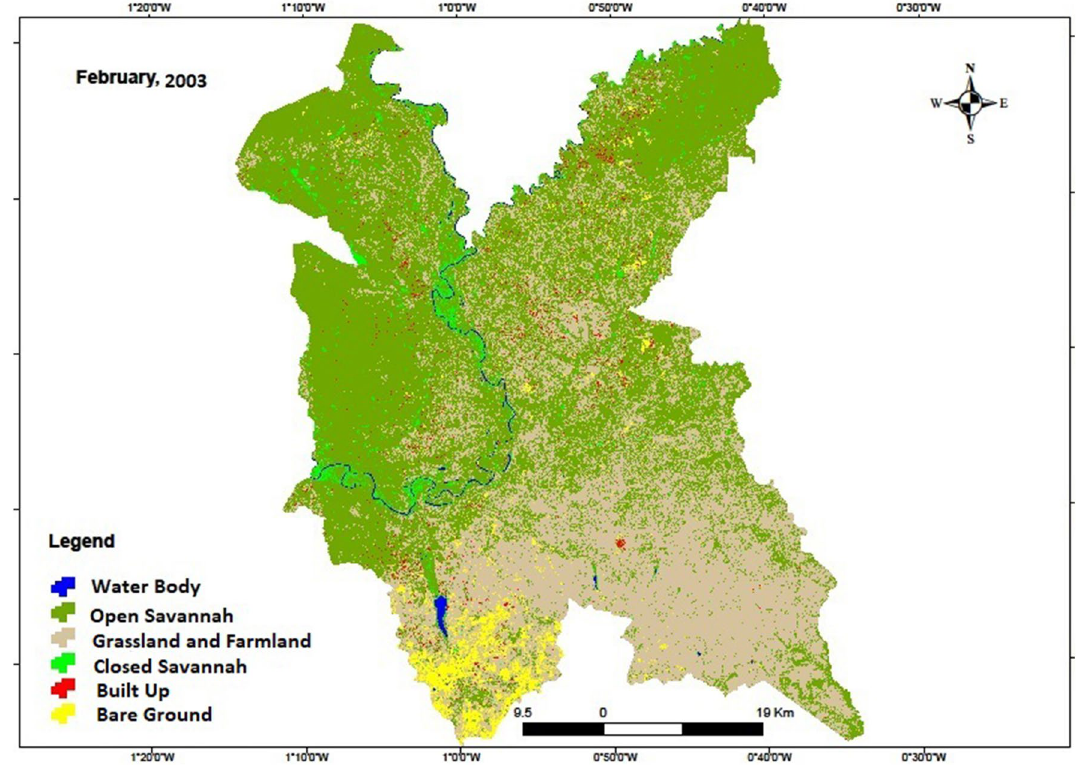
Fig. 5 Land use and land cover map of the Nawuni Catchment in